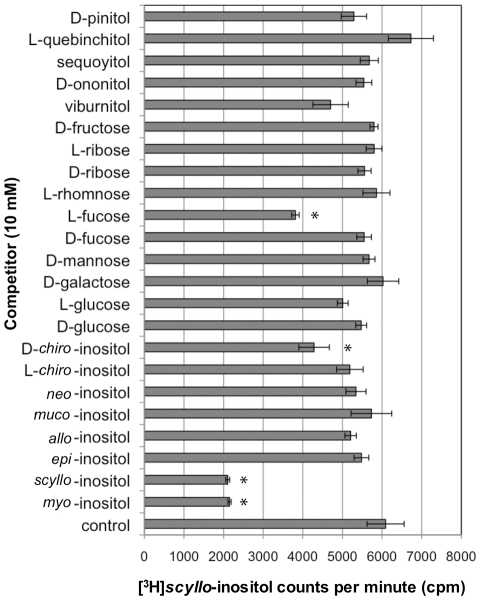

scyllo-Inositol-(2-3H) transport in HEK 293 cells.
scyllo-Inositol transport in the presence of inositol and sugar isomers was examined by measuring scyllo-inositol-(2-3H) transport in the presence of each of those potential substrates. For the control experiment, scyllo-inositol-(2-3H) transport was quantified in the absence of any added compounds. Cells were incubated for 3 hours in medium containing 100 µM of scyllo-inositol-(2-3H) in the presence or absence of 10 mM of potential inositol or sugar isomer transport competitors and the resulting radioactivity in the cells was measured (n = 3 wells per variable; * = p<0.05).